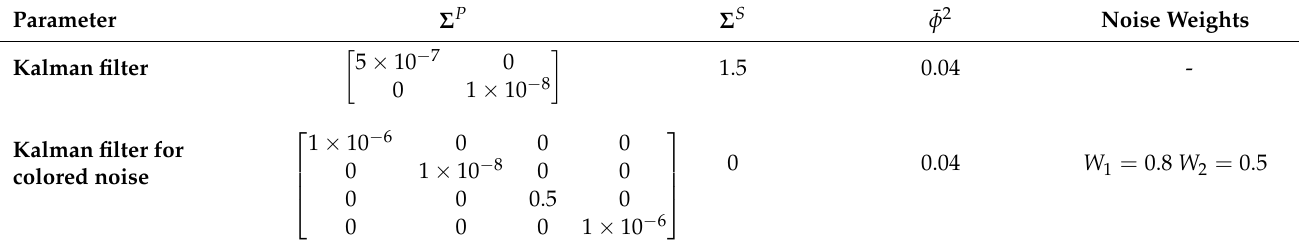
Table 4. Values of the parameters used in this work (in SI units). In this work, both the simple Kalman filter presented here, and the previous version in [11] were used with the same parameters for a fair comparison. Note that the Σ S for the Kalman filter for colored noise is null. The reason is that the measurement noise is contained in the third row of the plant